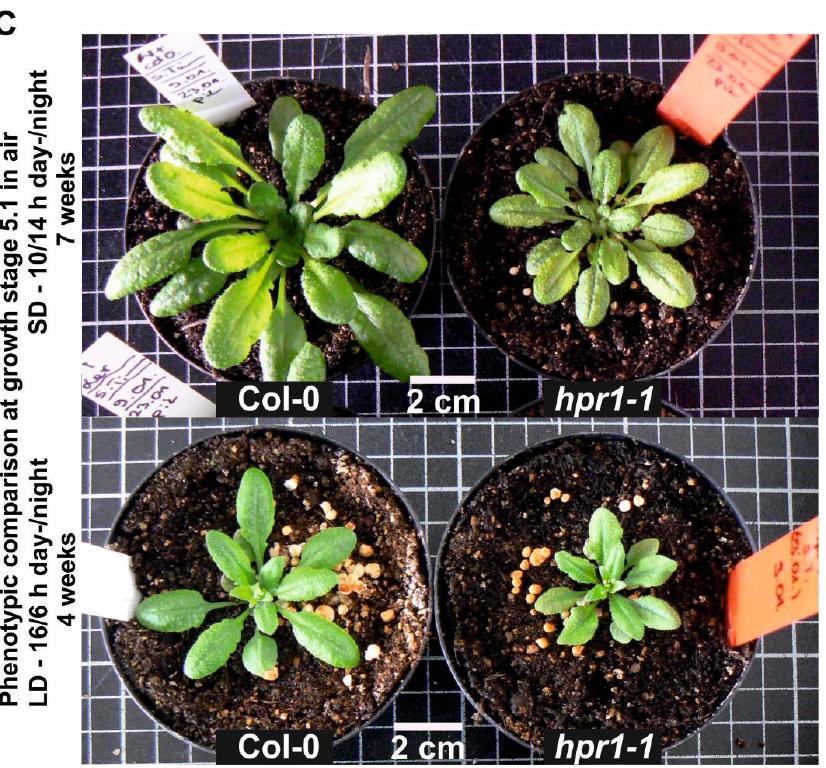
Figure A2. Phenotype of wild-type and hpr1 mutant plants at different growth stages and conditions. ( A ) The wildtype in comparison to hpr1-1 grown in normal air (390 ppm CO 2 ) for 5 weeks in a 12/12 h day/night cycle. Data presented in Figures 1–3 were obtained from plants at this specific growth stage. Scale bar within the picture is 2 cm. ( B ) Phenotype of the wildtype (Col-0 and Ler) and two independent HPR1 mutant alleles ( hpr1-1 and hpr1-2 ; [33]) grown in normal air (390 ppm CO 2 ) for ~7 weeks in a 12/12 h day/night cycle. The photograph illustrates that at this stage the growth retardation of hpr1 mutants is minor and onset of flowering similar between the mutants and the wildtype. Therefore, the metabolome analysis during development is comparable between both genotypes. ( C ) Phenotype at growth stage 5.1 [41] in short day (upper panel, after ~7 weeks) and long day (lower panel, ~4 weeks), at which leaf-material for metabolome analysis presented in Figure 6 was taken in both photoperiods. Scale bar within the picture is 2